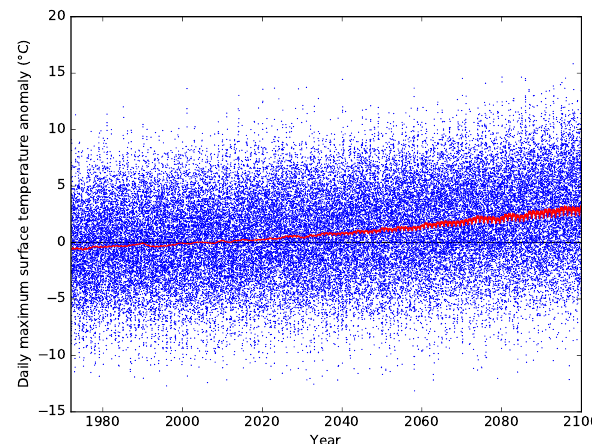
Figure 3. Annual mean global mean surface temperatures calcu- lated from the CMIP5 AOGCM simulations under the RCP8.5 sce- nario (coloured solid lines). The annual mean global means from the HadAM3P (dashed lines) and MAGICC (grey lines) for RCP8.5 are also shown.